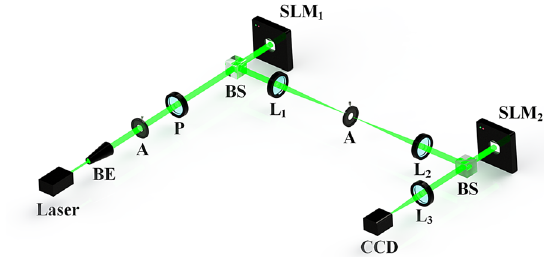
Figure 3: Diagram of the experimental setup. A Gaussian beam generated by the laser is expanded and collimated by a beam expander (BE). Then the beam passes through an aperture ( A ) and a polarizer( P ), which are usedto improve thebeamquality andadjust intensity. The well-prepared beam passing through the beam splitter is modulated by the spatial light modulator (SLM 1 ). The truncated beam re fl ected by SLM 1 is separated by a 4 f system con- sisted of lenses ( L 1 and L 2 , f = 200 mm) and an aperture. Then the truncated beam is modulated by the SLM 2 after re fl ecting from a beam splitter. After that, a lens L 3 ( f = 150 mm) is used to focus the beam to a 2DPIMA, where a charge-coupled device (CCD) measures its intensity pro fi le. two OAM states l = 1 and l = 2. The opening angle of these two objects is π /2 and 7 π /4, respectively. Firstly, the angular velocity of both objects was set to π /6 rad/s (counterclockwise rotation). During the experiments, the diffraction fi eld was captured per second, totally of 12 times. The fi rst and seventh measurements of the 2DPIMA are shown in Figure 4. In each 2DPIMA, the left four collinear spots and the right four collinear spots are used to calculate the real-time relative phase of OAM states l = 1 and l = 2, respectively. Among them, the results of the simulation and experiment of the fi rst object are shown in